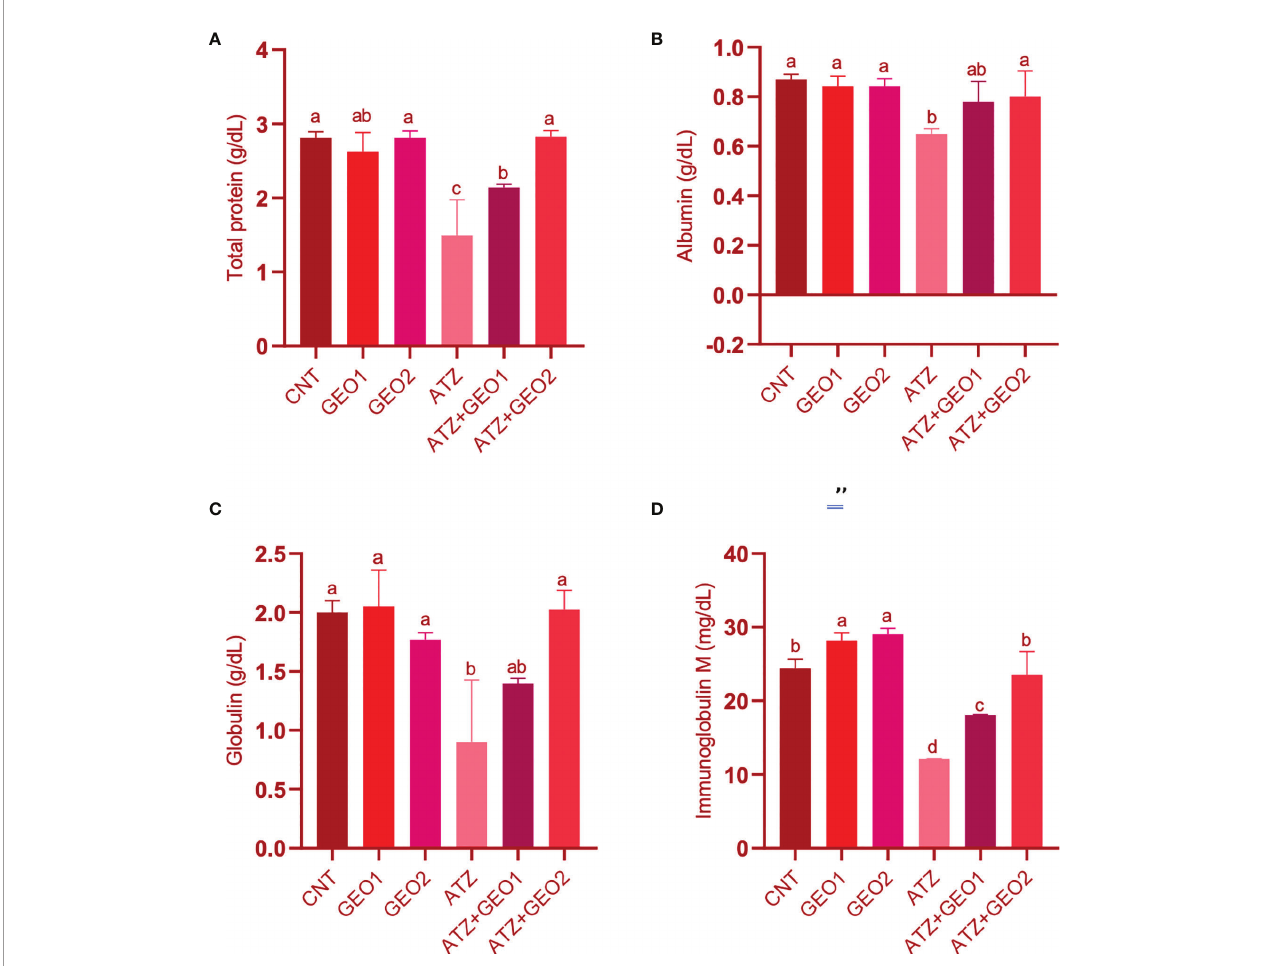
FIGURE 1 | Blood proteins (A – C) and immunoglobulin M (D) levels of Nile tilapia in response to sub-lethal ATZ exposure and/or dietary supplementation with GEO for 60 days. Values are expressed as means ± S.E.M (n = 9). Values that are not sharing a common letter differ signi fi cantly at P <